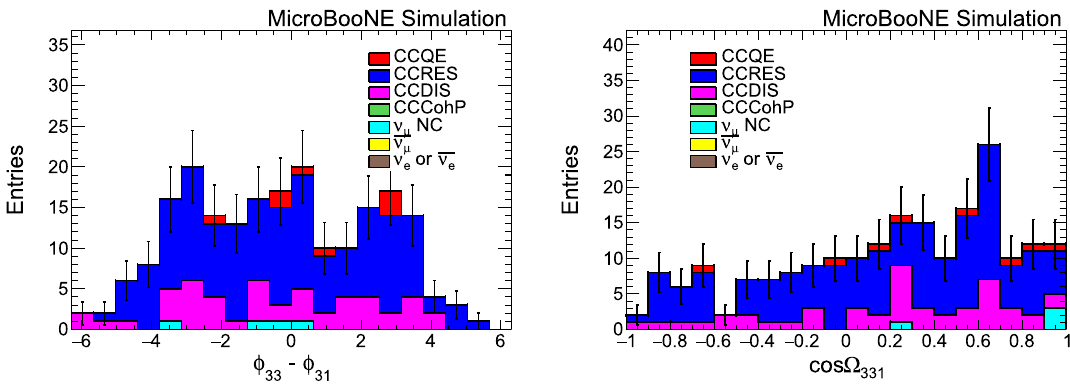
Fig. 38 Multiplicity = 3 φ 3 − φ 1 distribution (left); cosine of opening angle distribution between first and third track (right) from GENIE default MC. Black error bars represent MC statistical uncertainties